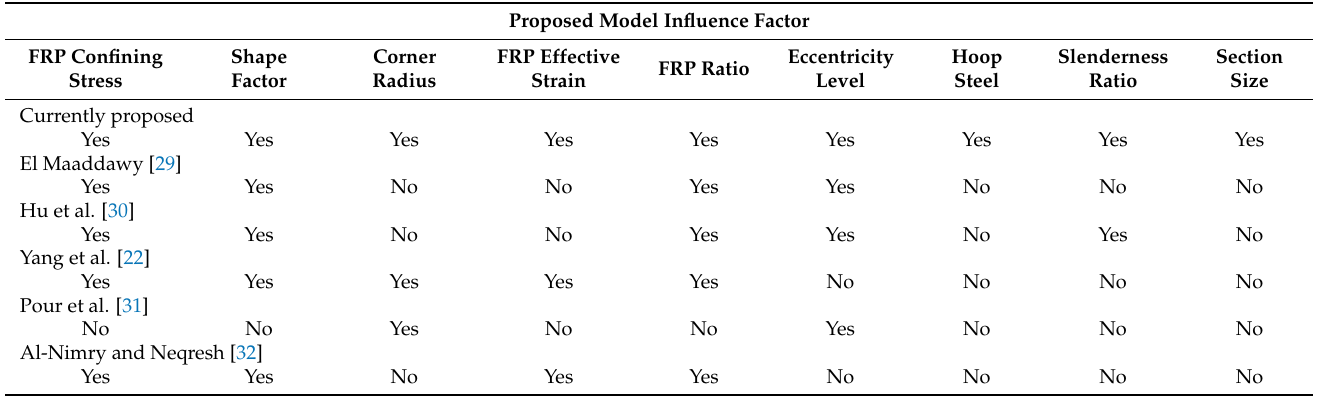
Table 1. Influence factors of existing model expressions of FRP-confined concrete under eccentric axial